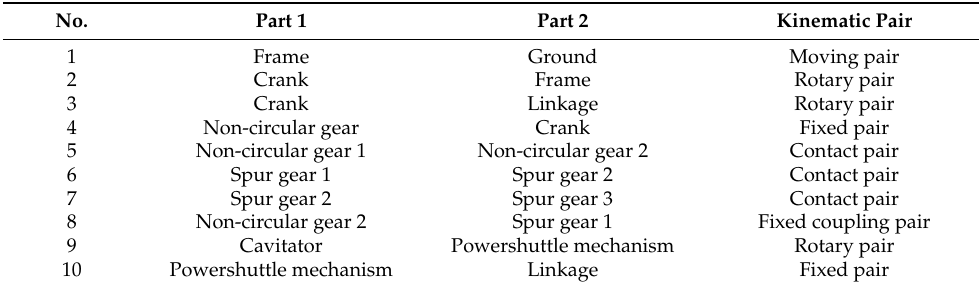
Table 1. Kinematic pair configuration table of multi-body dynamics model.